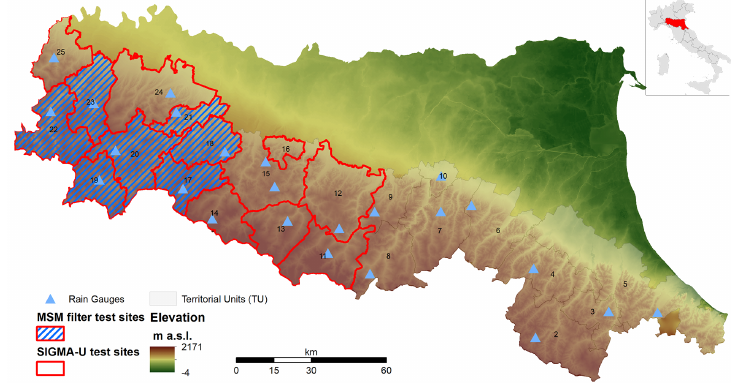
Figure 1. Test site showing the partition in territorial units (TUs) and highlighting the TUs used as test